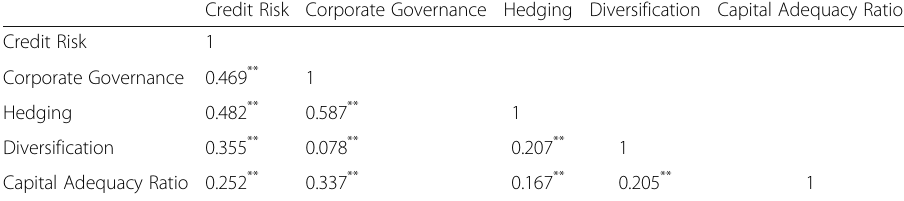
Table 2 Correlations Credit Risk Corporate Governance Hedging Diversification Capital Adequacy Ratio Credit